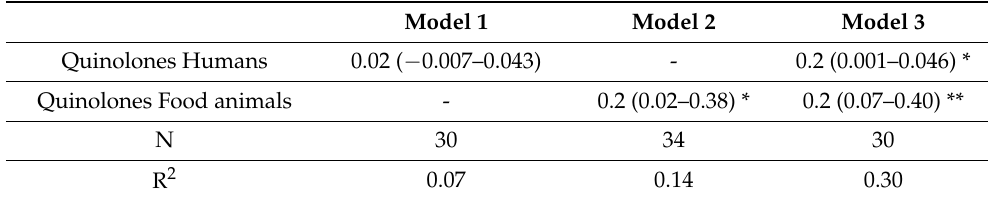
Table 1. Linear regression models testing the country-level association between quinolone consump- tion in food animals/humans and the prevalence of ciprofloxacin resistance expressed as a percentage (coefficients (95% confidence